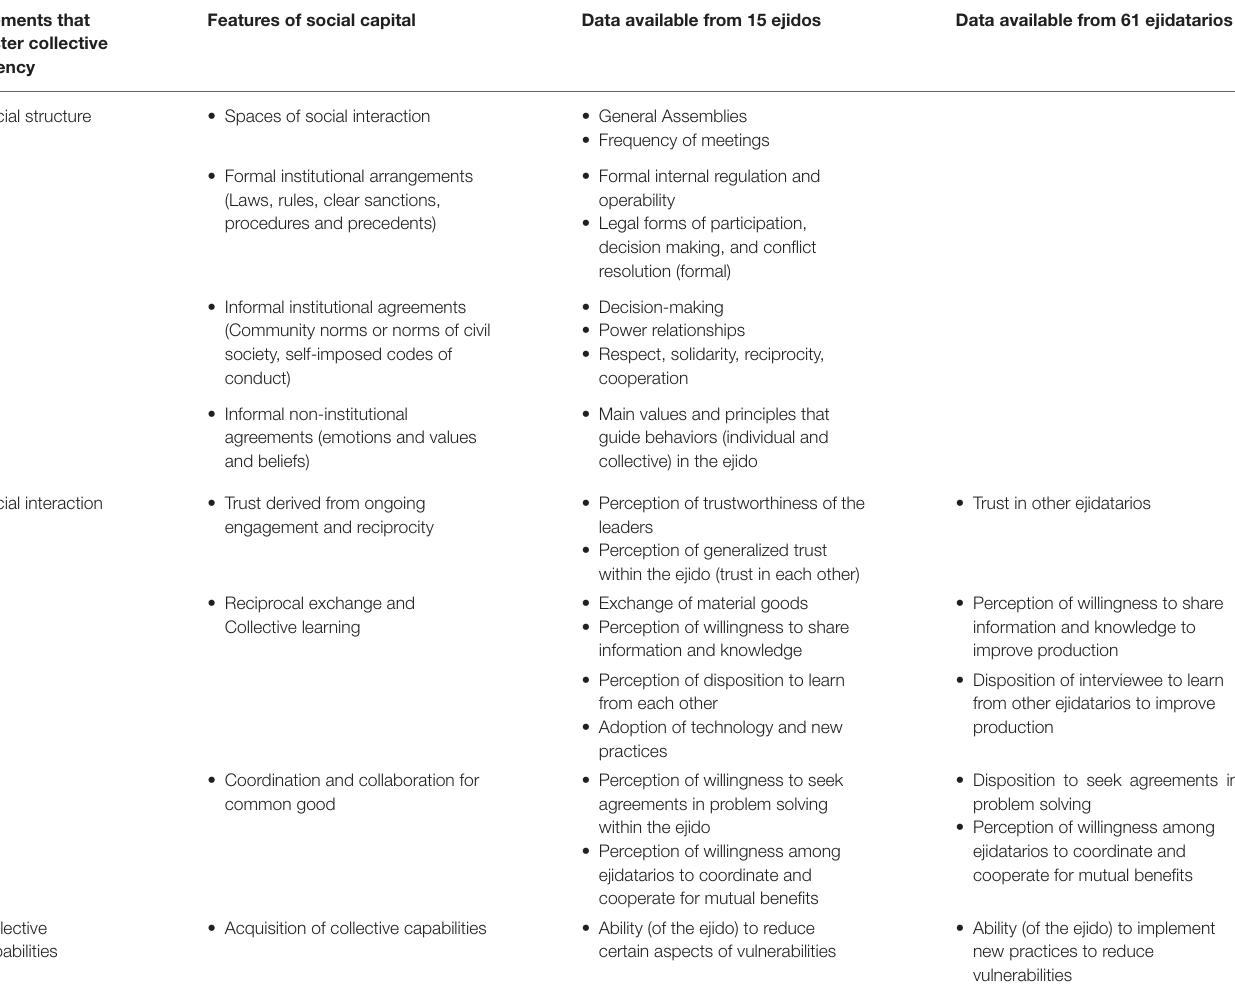
TABLE 1 | Elements that foster collective agency from the social capital perspective and on the basis of the data available. Elements that foster collective